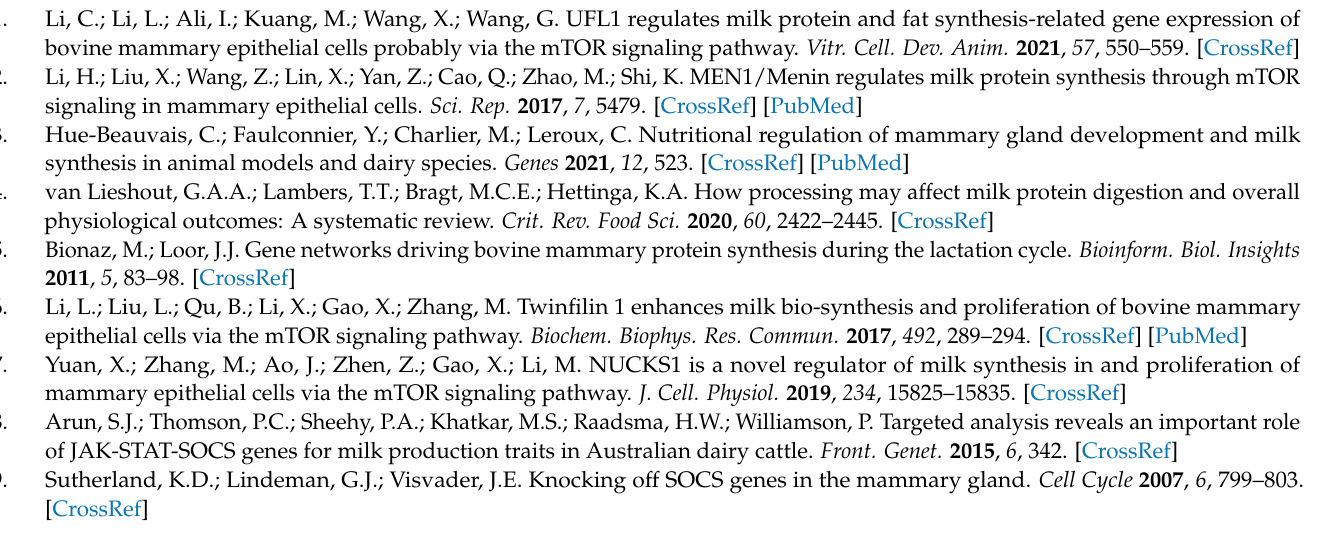
Table S2: The primer of qPCR; Table S3: Primers used for isolation and deletion of buffalo SOCS1 promoter